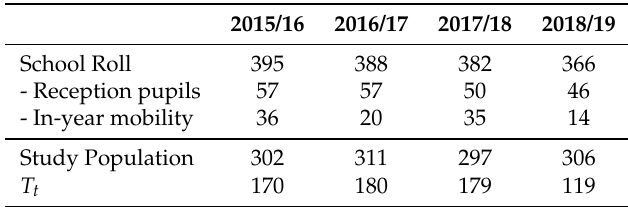
Table A1. School roll and study population size for 2015/16, 2016/17, 2017/18, and 2018/19.